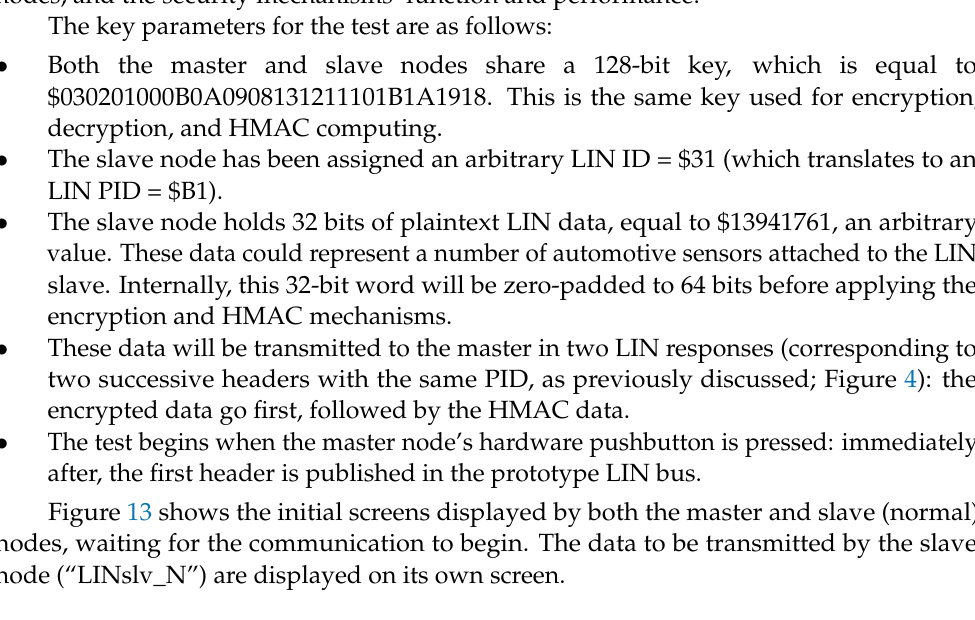
Figure 13. Initial states displayed after reset or power-on: ( a ) master node, ( b ) normal slave node.